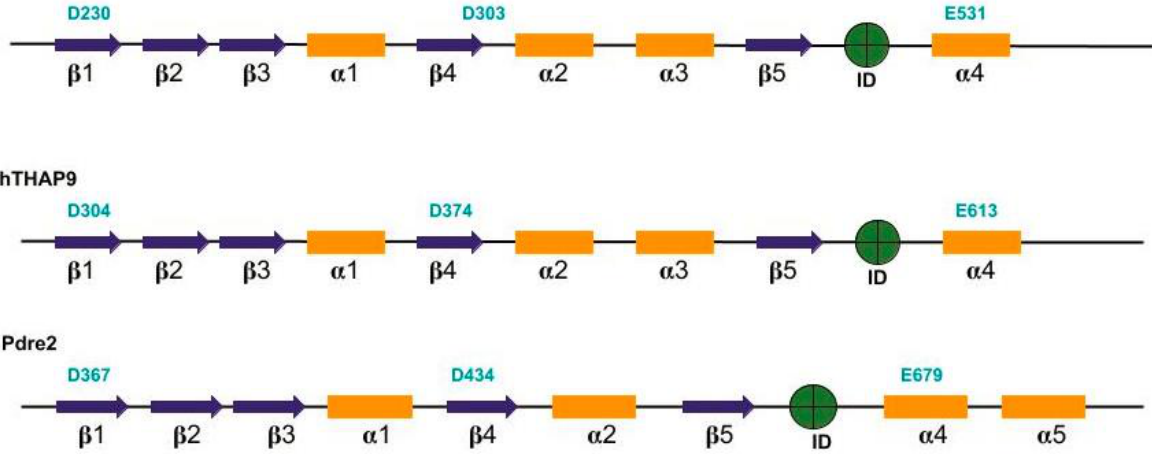
Figure 1. Predicted RNase-H fold in Drosophila, human and zebrafish THAP9. DDE motifs for each homolog are represented in bold (cyan) above its putative location. Blue arrows indicate beta sheets and yellow bars represent alpha helices. Insertion domains for each homolog (DmTNP (residues 339–528) [12], hTHAP9 (residues 415–604), Pdre2 (residues 475–670)) are shown in green circles.